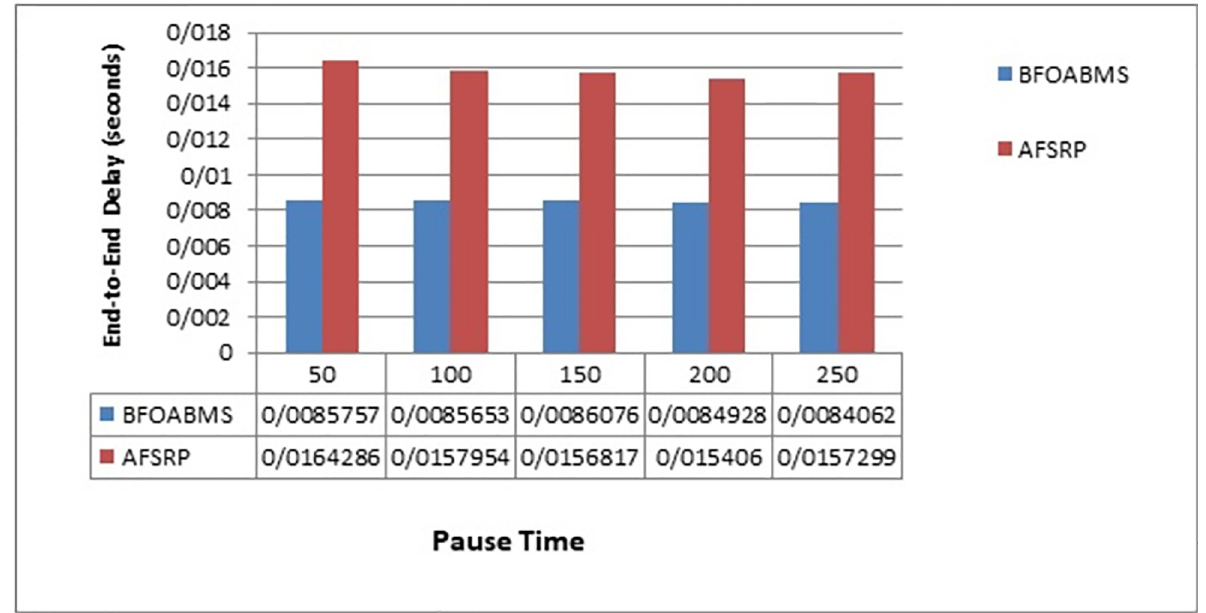
Fig 7. End-to-end